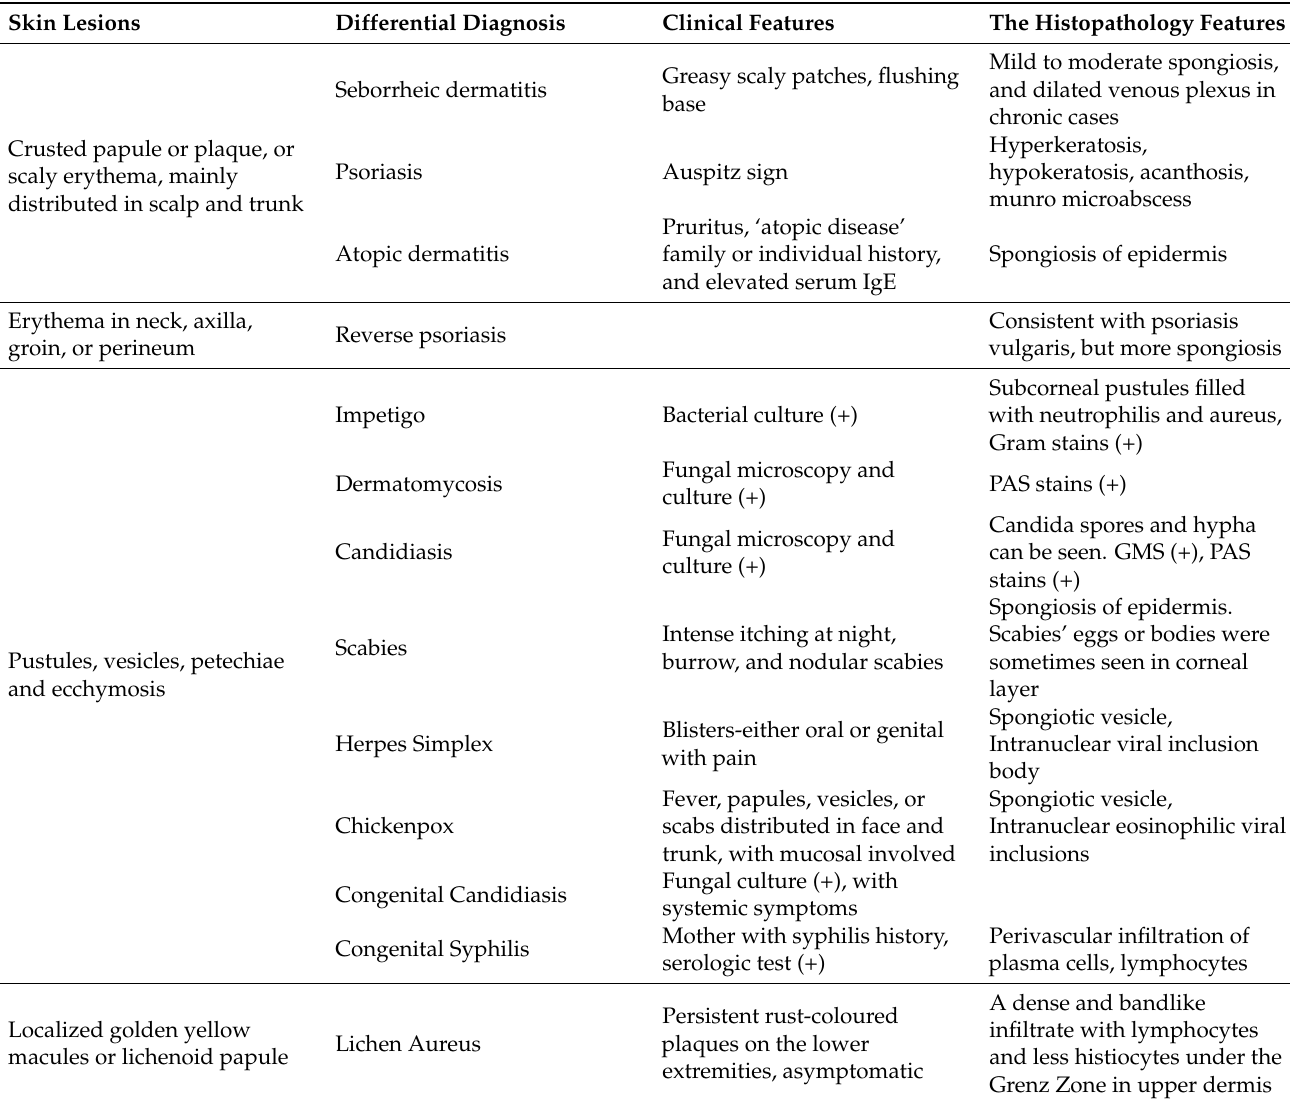
Table 4. Differential diagnosis of cutaneous presentation of